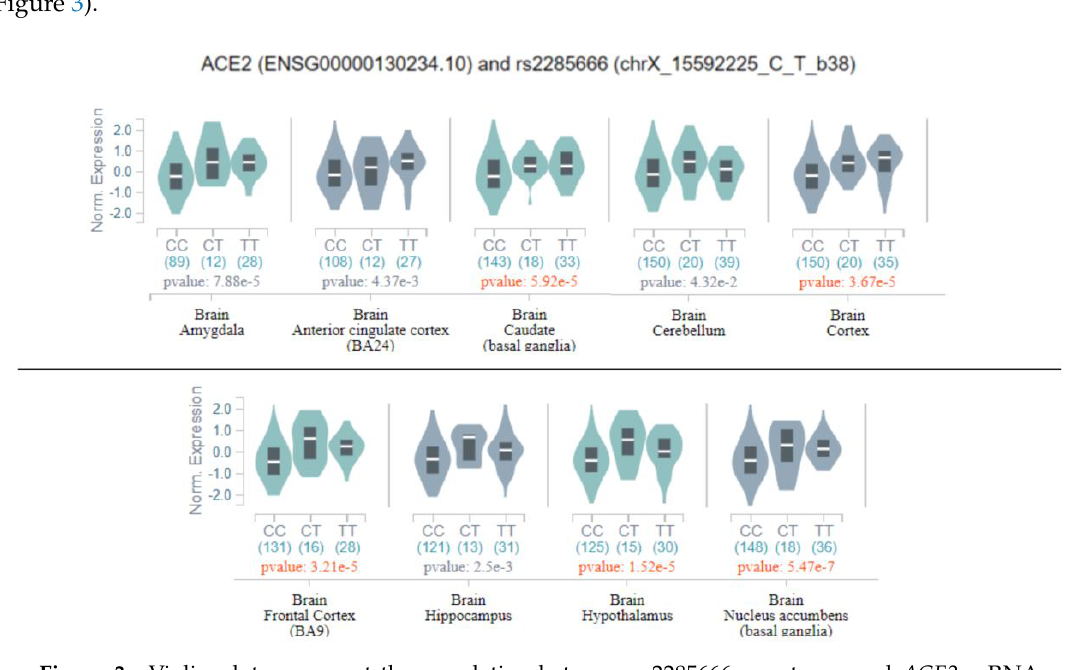
Figure 3. Violin plots represent the correlation between rs2285666 genotypes and ACE2 mRNA expression in different brain tissues. The reports on the x -axis are the genotypes, with the correspondent counts in brackets. On the y -axis, the normalized expression of ACE2 is reported. Moreover, a p- value of for the variant significance is reported. The figure has been obtained from Genotype-Tissue Expression (GTex) [26].